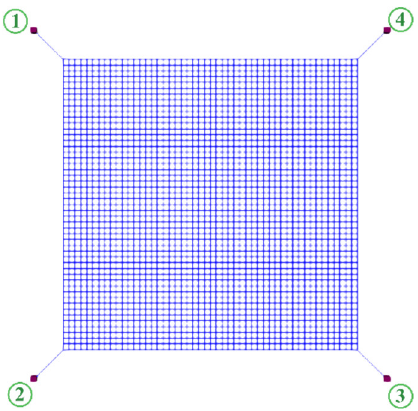
Figure 3. The deployed configuration of the flexible net with four actuators. Table 2. Simulation parameters of the debris.